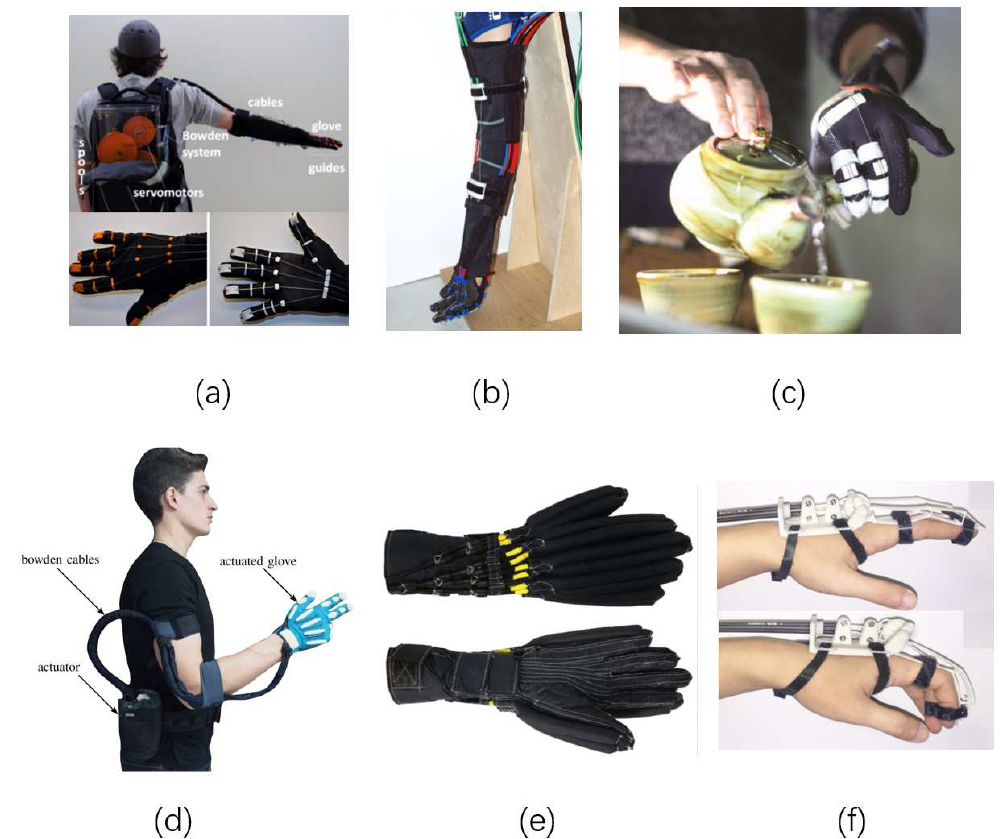
Figure 1. Soft rehabilitation and nursing-care robots based on tendon-driven in upper limb. ( a – c ) is reprinted from [19–21], respectively. ( d – f ) is reprinted from [26,27,34],